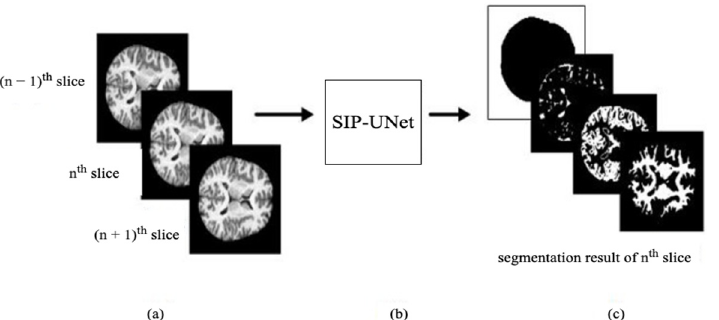
Figure 2. Illustration of SIP-UNet ( a ) input comprises three consecutive slices where (n – 1) th slice represents the early slice, n th slice represents the central slice, and (n + 1) th slice represents the later slice, ( b ) the proposed SIP-UNet model, and ( c ) output of the proposed model which generates the segmented result of n th slice.